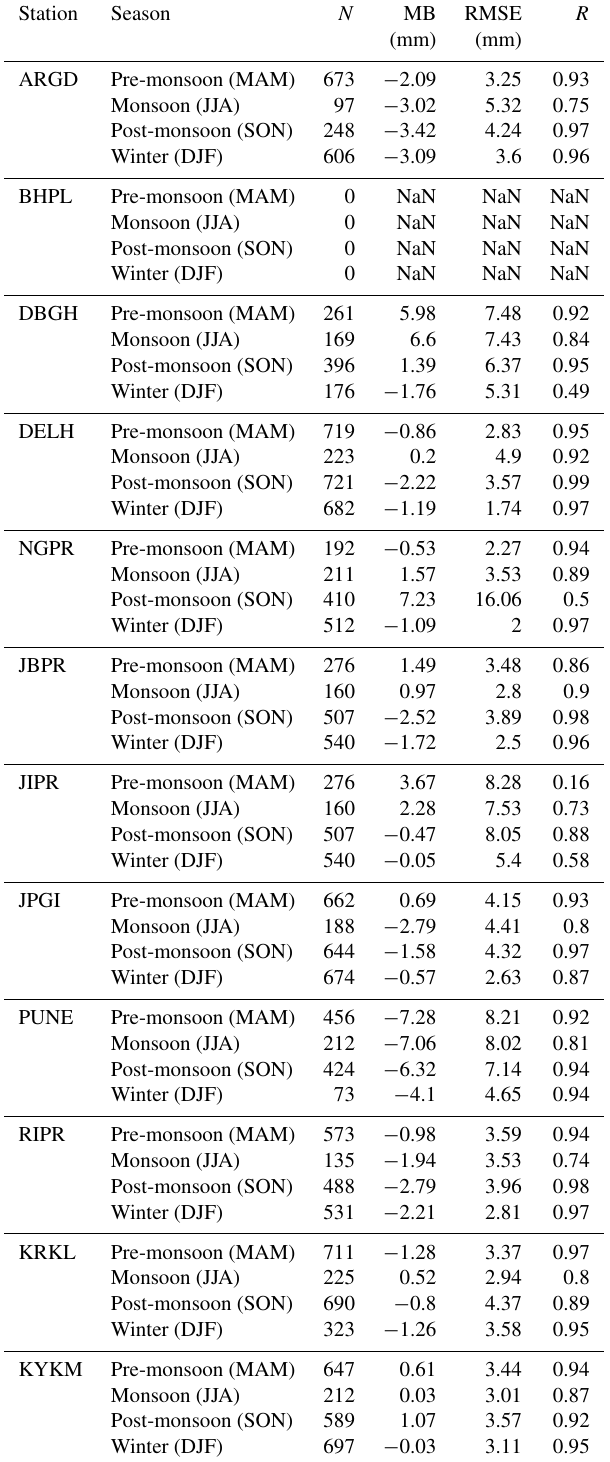
Table 6. Statistical seasonal analysis of retrievals of IPWV from CAMS and GNSS data. NaN indicates no availability of observa- tional